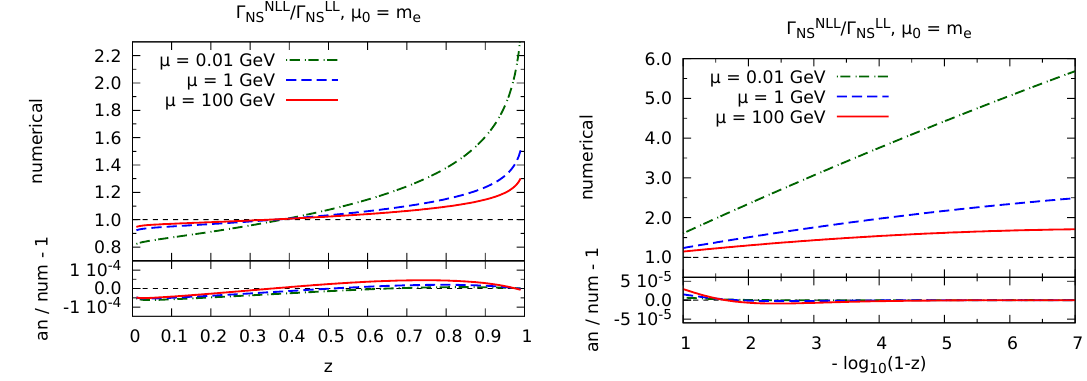
Figure 9 . Main frames: ratios of NLL over LL PDF, as computed with the numerical code, for the non-singlet, and for three di(cid:11)erent hard-scale choices. Insets: ratio of the ratio shown in the main frame, over the same quantity computed analytically, minus one.